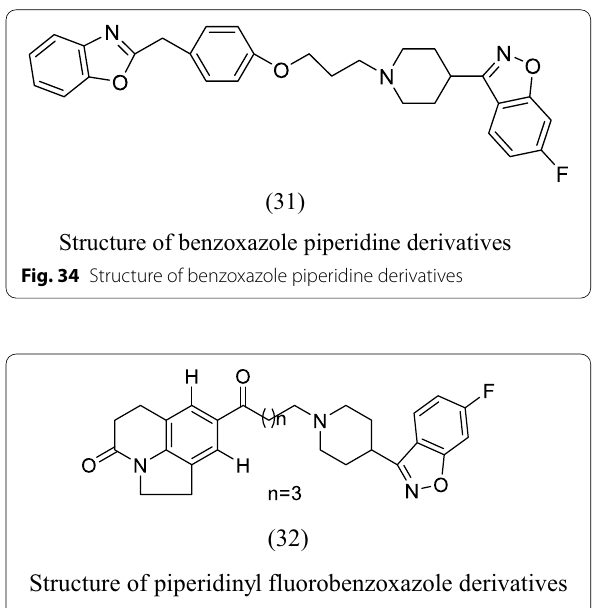
Fig. 35 Structure of piperidinyl fluorobenzoxazole derivatives